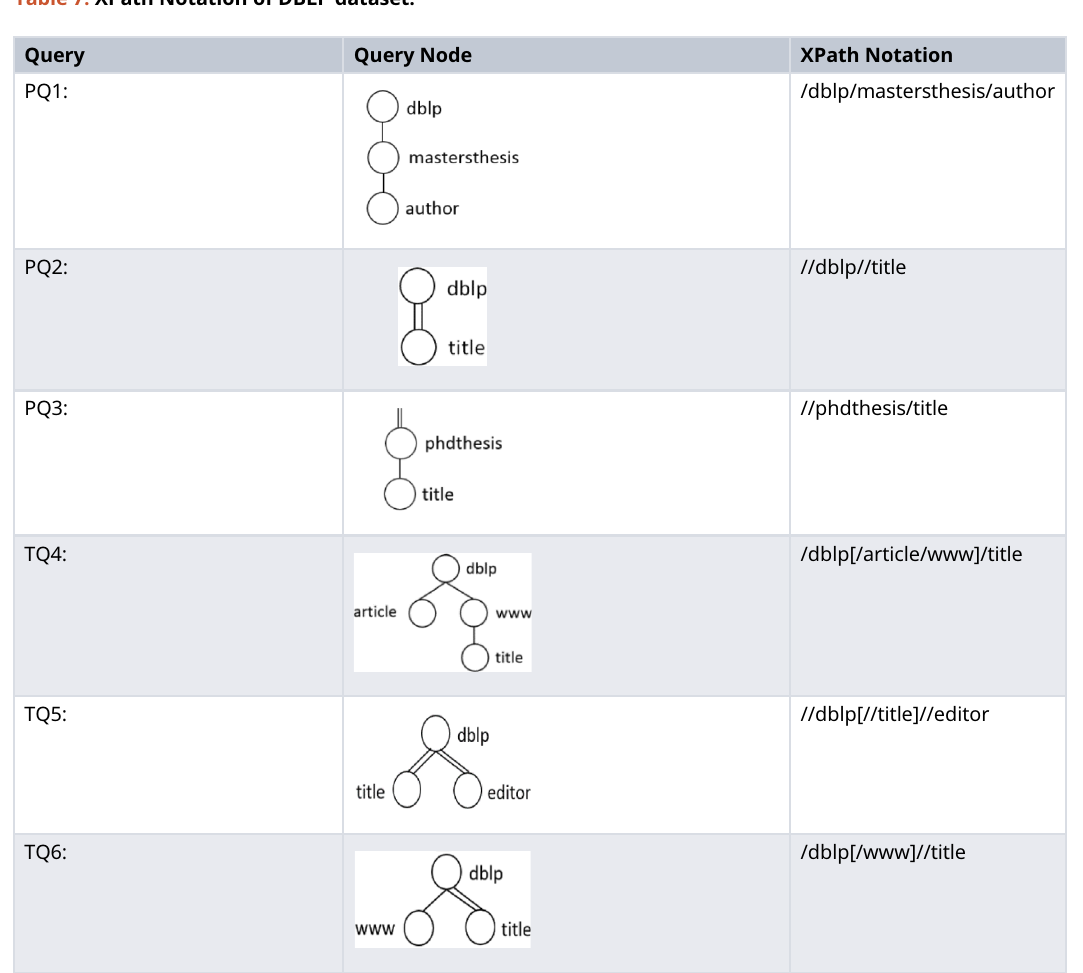
Table 7. XPath Notation of DBLP